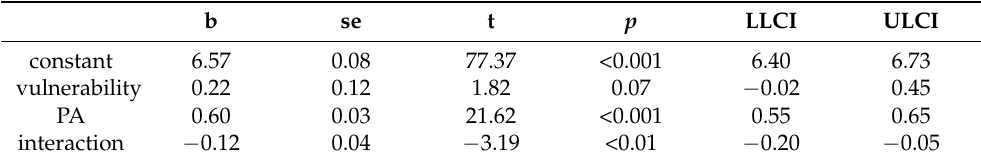
Table 5. Regression analysis of SWB on PA, considering the moderating effect of vulnerability.